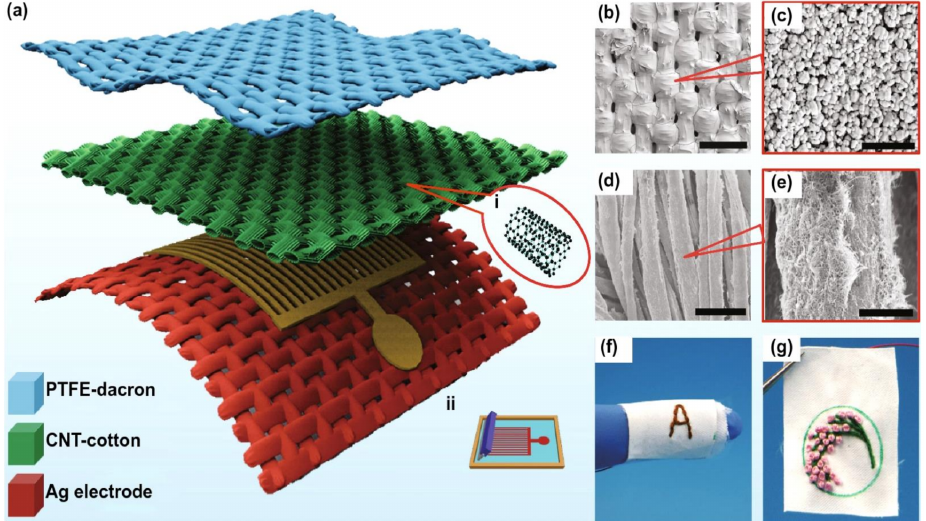
Figure 4. F-TENG schematic diagram highlighting the molecular structure i) and the screen-printing process diagram of CNTs ii) ( a ); SEM images, at different magnifications, of the PTFE and CNT’s surface coating the fabric ( b – e ). Images of the F-TENG applied on a finger ( f ) or in the shape of needlework ( g )